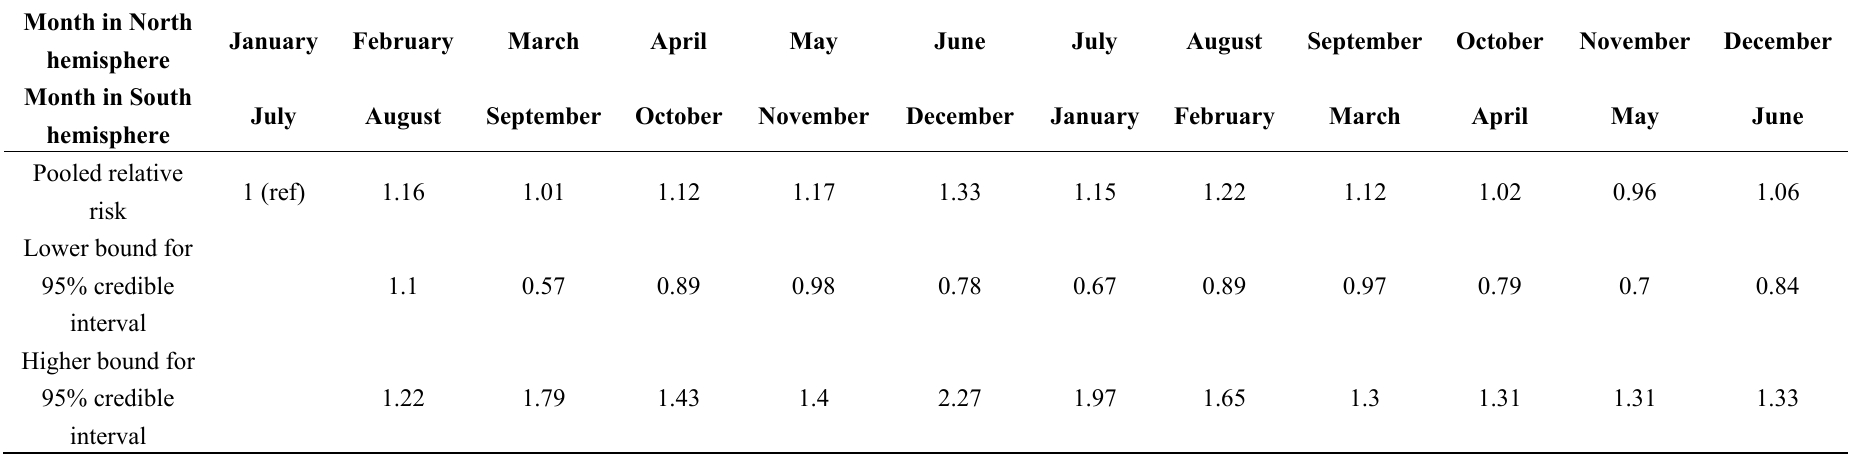
Table A2. Pooled relative risks and 95% credible interval for the association between month of conception on preeclampsia incidence after excluding